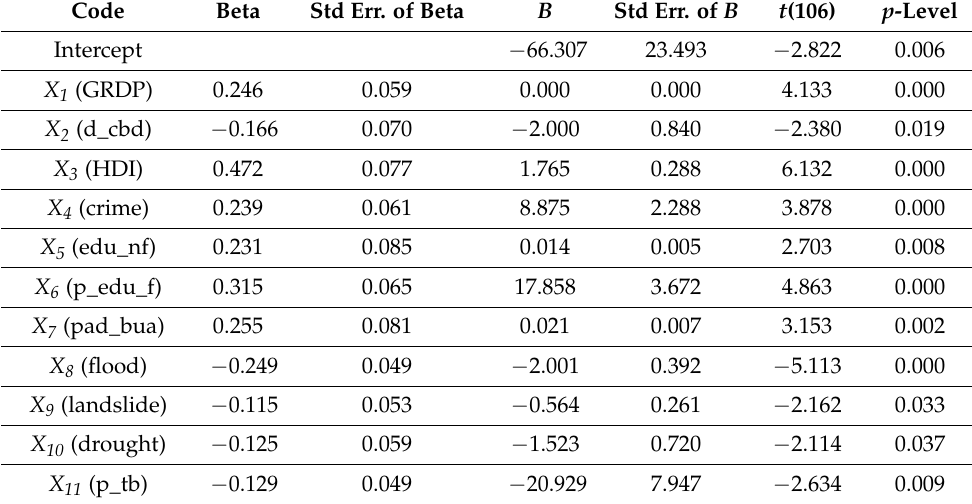
Table 2. OLS regression